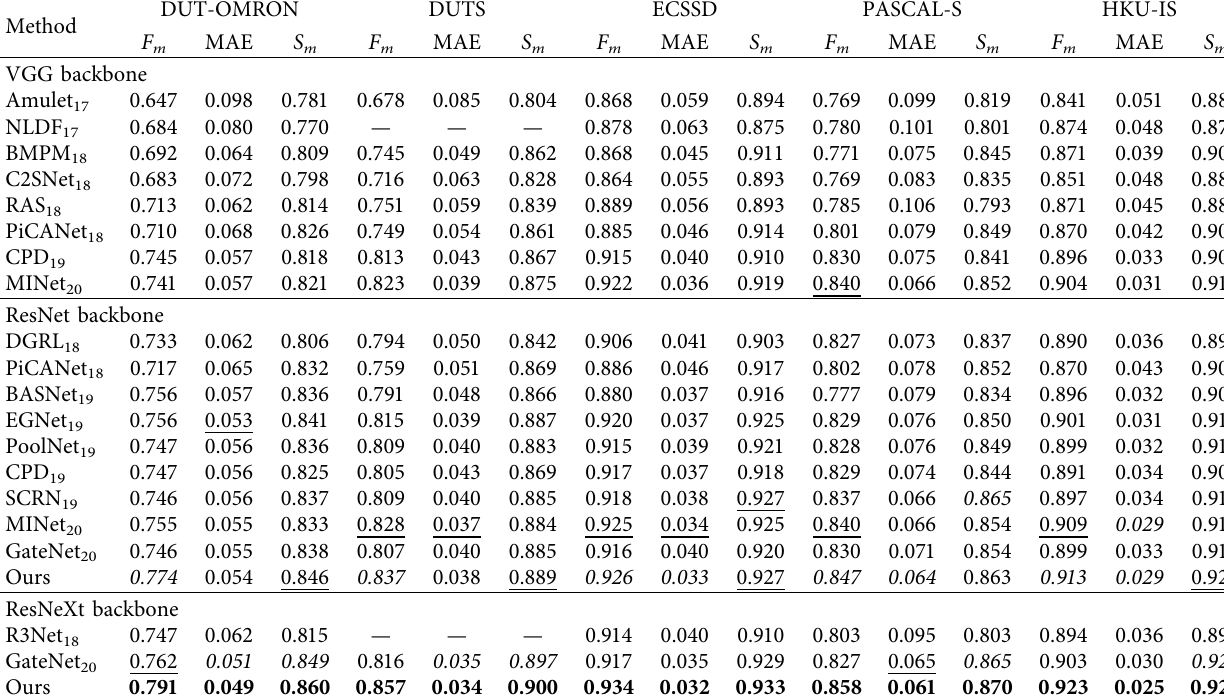
Bold, italics, and underline indicate the best, second best, and third best performance. “—” means that the author has not provided corresponding saliency